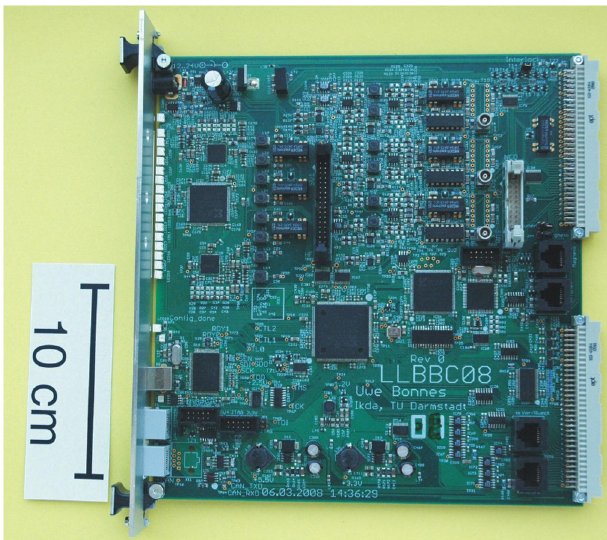
FIG. 4. (Color) Picture of the FPGA